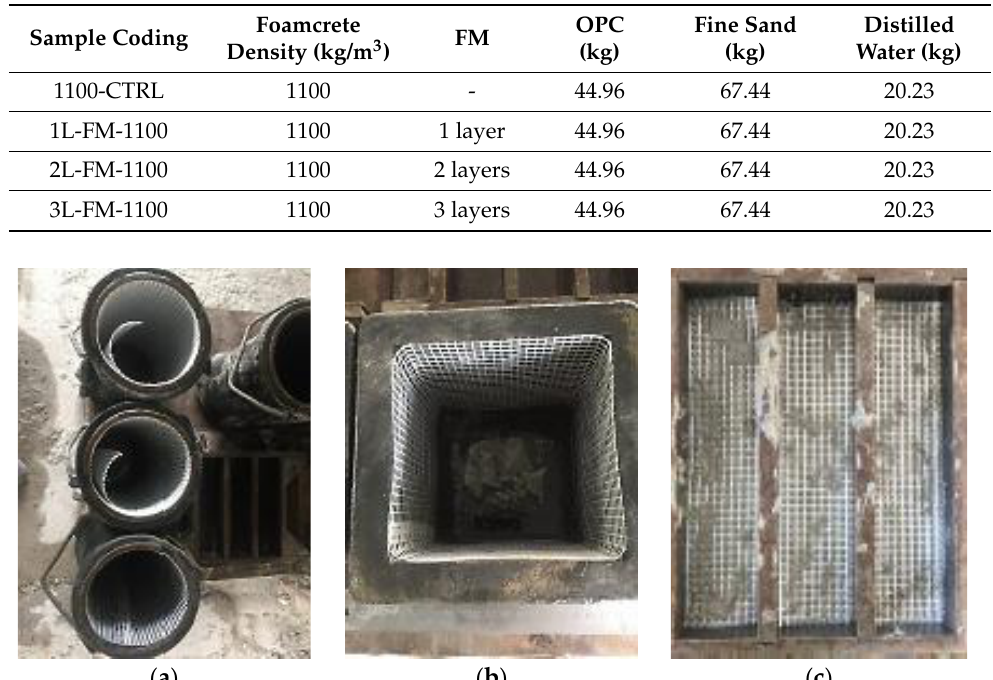
Figure 3. Fiberglass meshes were cut according to the size of the moulds. ( a ) cylinder ( b ) cube ( c ) prism.